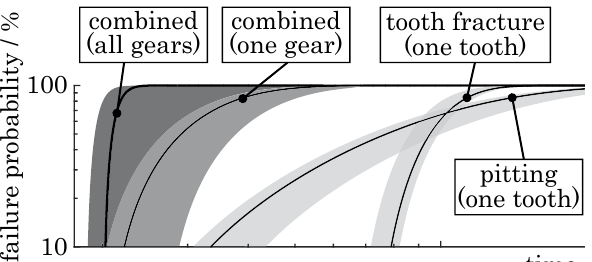
Figure 11: Failure performance variance of the pinion, broken down by failure modes, Load: 150 t, Wind speed: Beaufort 5